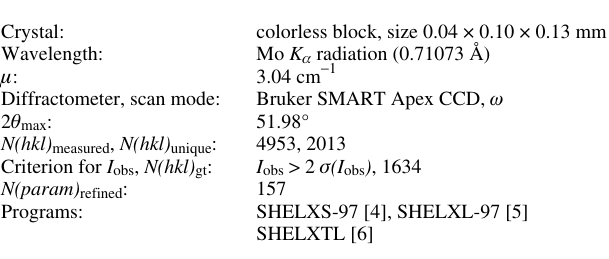
Table 1. Data collection and handling.